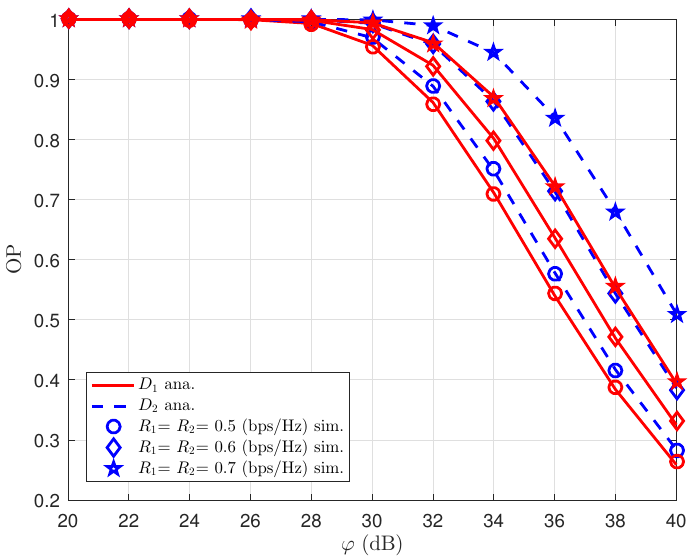
Figure 4. OP versus ϕ for different R 1 = R 2